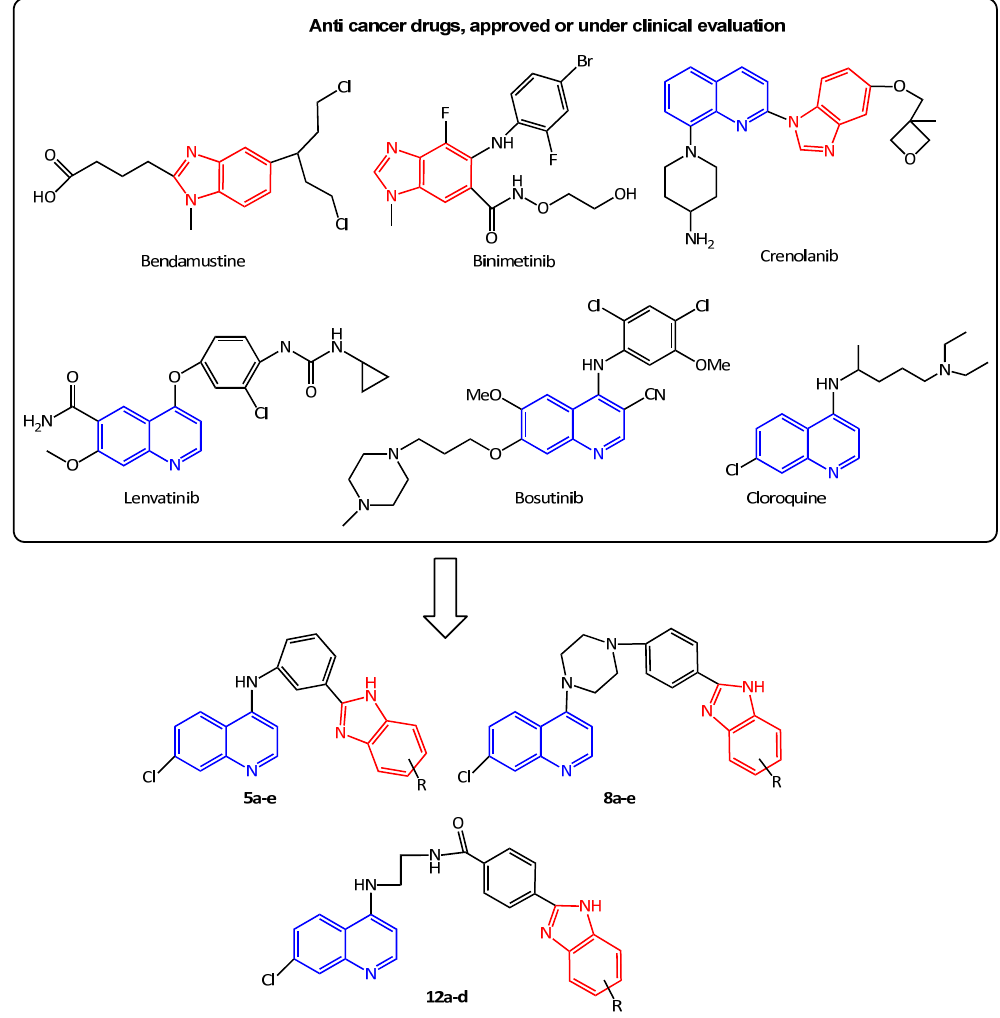
Figure 1. Design of the novel 7-chloro-4-aminoquinoline-benzimidazole hybrids.